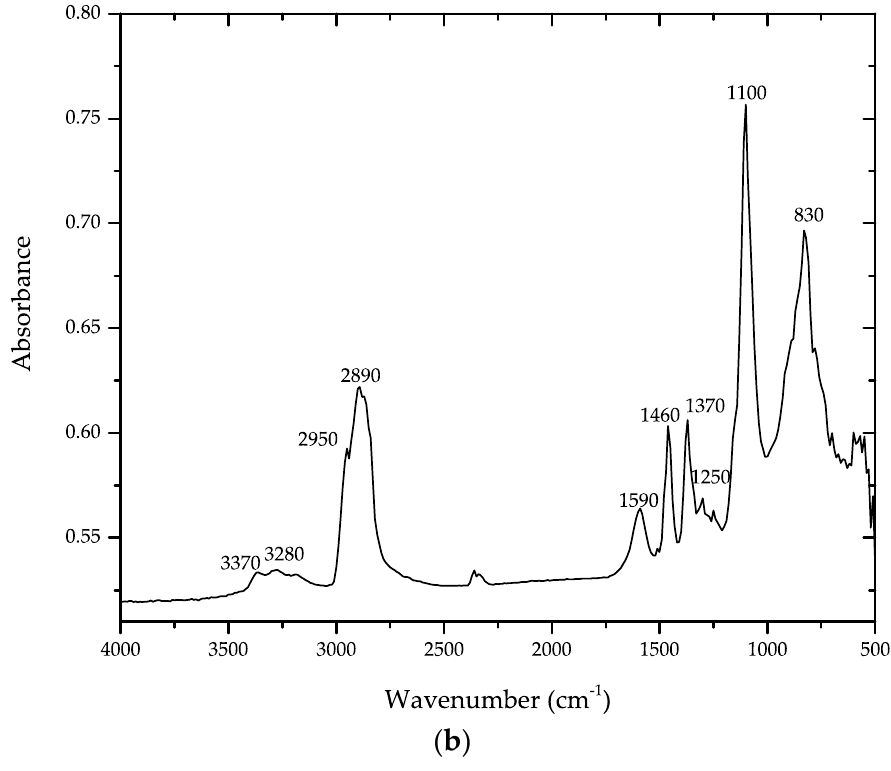
Figure 1. FTIR spectra of ( a ) base epoxy resin Resoltech ® 1070 based on DGEBPA, and ( b ) primary amine-based hardener Resoltech ® 1074.